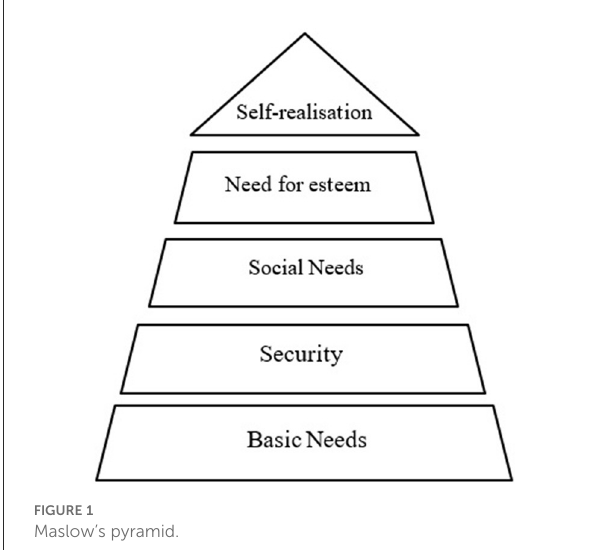
FIGURE1 Maslow’s